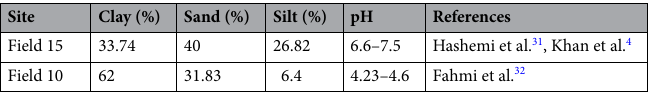
Table 3. Characterization of soil properties of the experimental